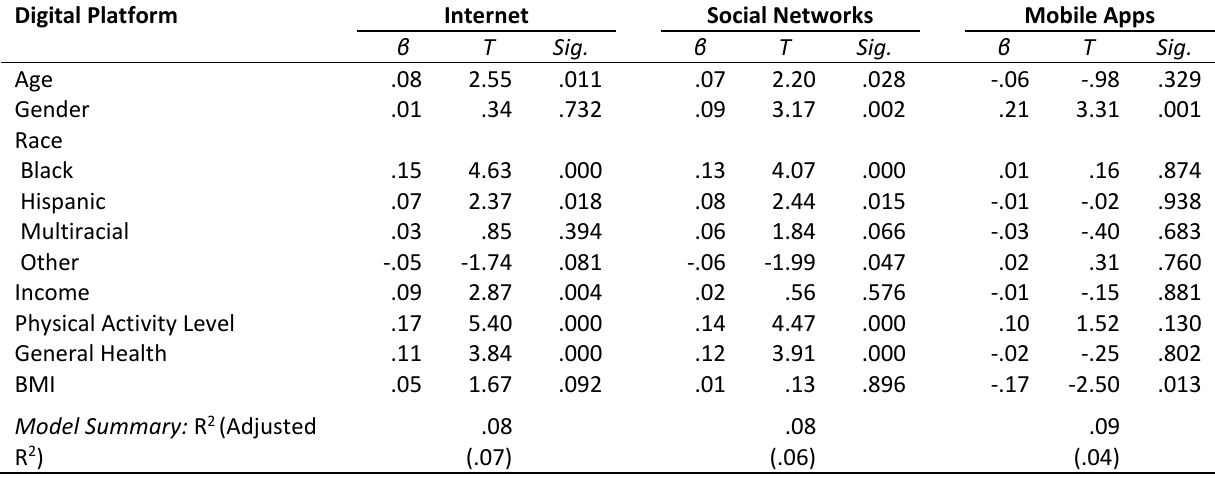
Table 1. Predictors of digital platform use for health-information seeking. Digital